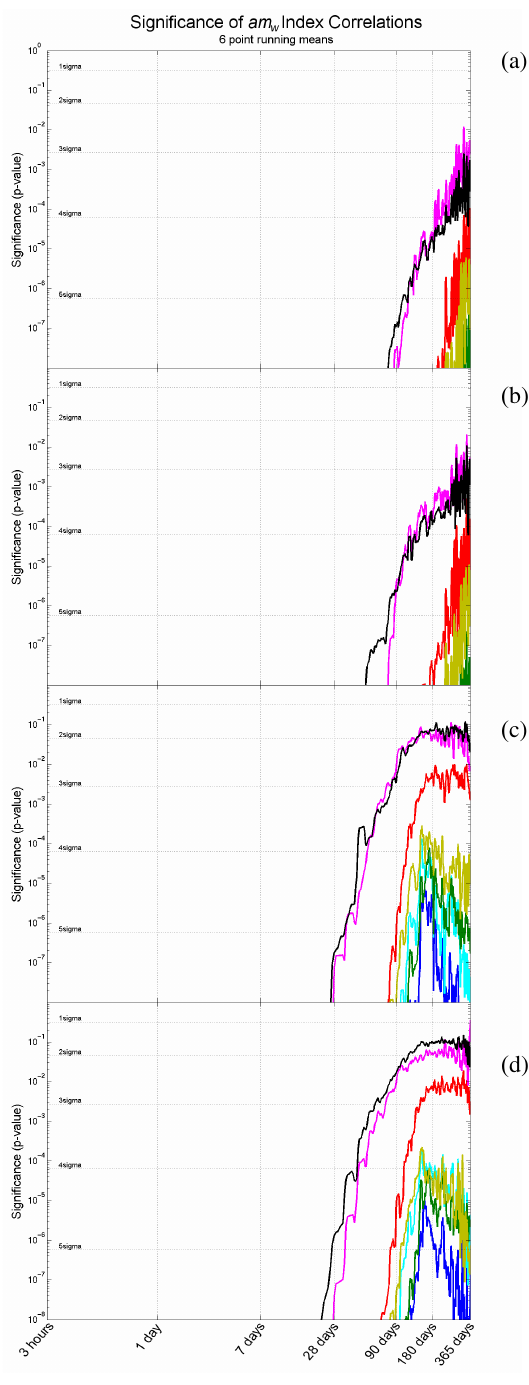
Fig. 11. Significance levels (p-values) of correlations from Fig. 10. The scale chosen means that values are only shown where they are below the 6 σ level ( p> ∼ 10 − 8 ).